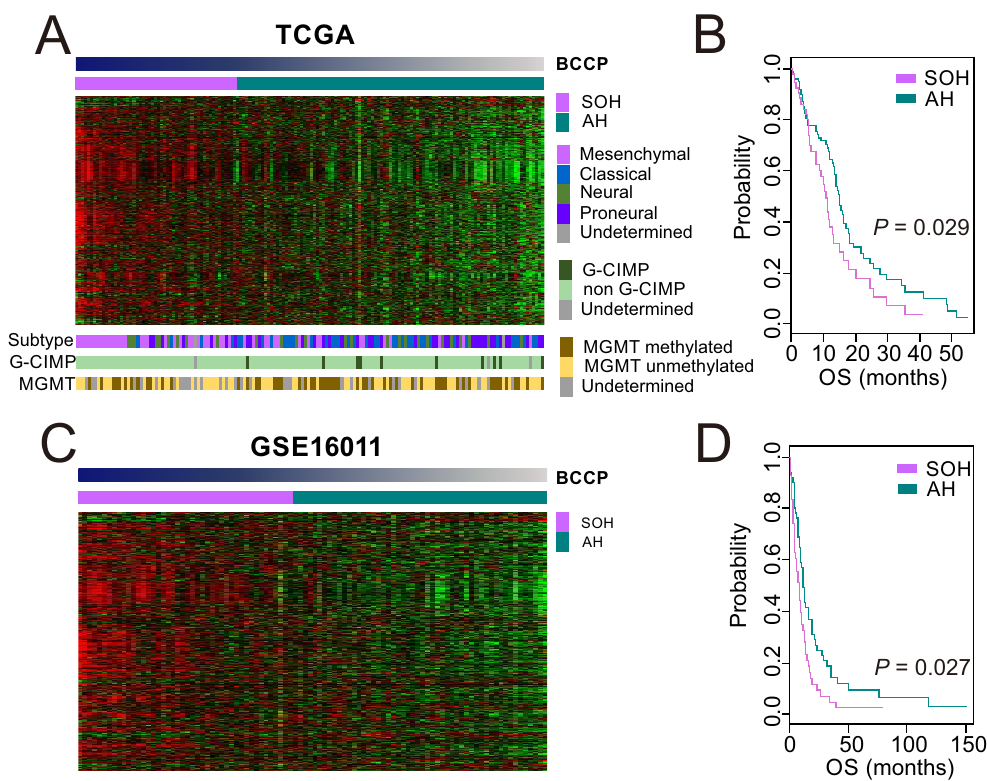
Figure 2. Association of the silence of Hippo pathway (SOH) signature with poor prognosis in patients with glioblastoma (GBM). ( A ) Heat map of gene expression patterns of GBM tumor samples from The Cancer Genome Atlas (TCGA; n = 154), which were stratified according to core SOH signature by the Bayesian covariate compound predictor (BCCP) classifier. Of 154 patient samples, 53 were placed in the SOH subgroup and 101 were placed in the active Hippo (AH) subgroup. The data are presented in matrix format in which rows represent individual genes and columns represent individual tumor samples. Samples are arranged according to SOH probability from BCCP. Mesenchymal subtypes were more common in the SOH subgroup, whereas proneural subtypes were more abundant in the AH subgroup ( p < 0.001). The incidence of glioma CpG island methylation phenotype (G-CIMP) and promoter methylation of methylguanine methyl transferase (MGMT) are indicated. ( B ) Kaplan–Meier plots of overall survival (OS) of patients in the SOH and AH subgroups in TCGA. ( C ) Heatmap of gene expression data from GBM tumors in GSE16011 (44 SOH and 52 AH). ( D ) Kaplan–Meier plots of OS of patients in the SOH and AH subgroups in GSE16011. p values were obtained using the log-rank